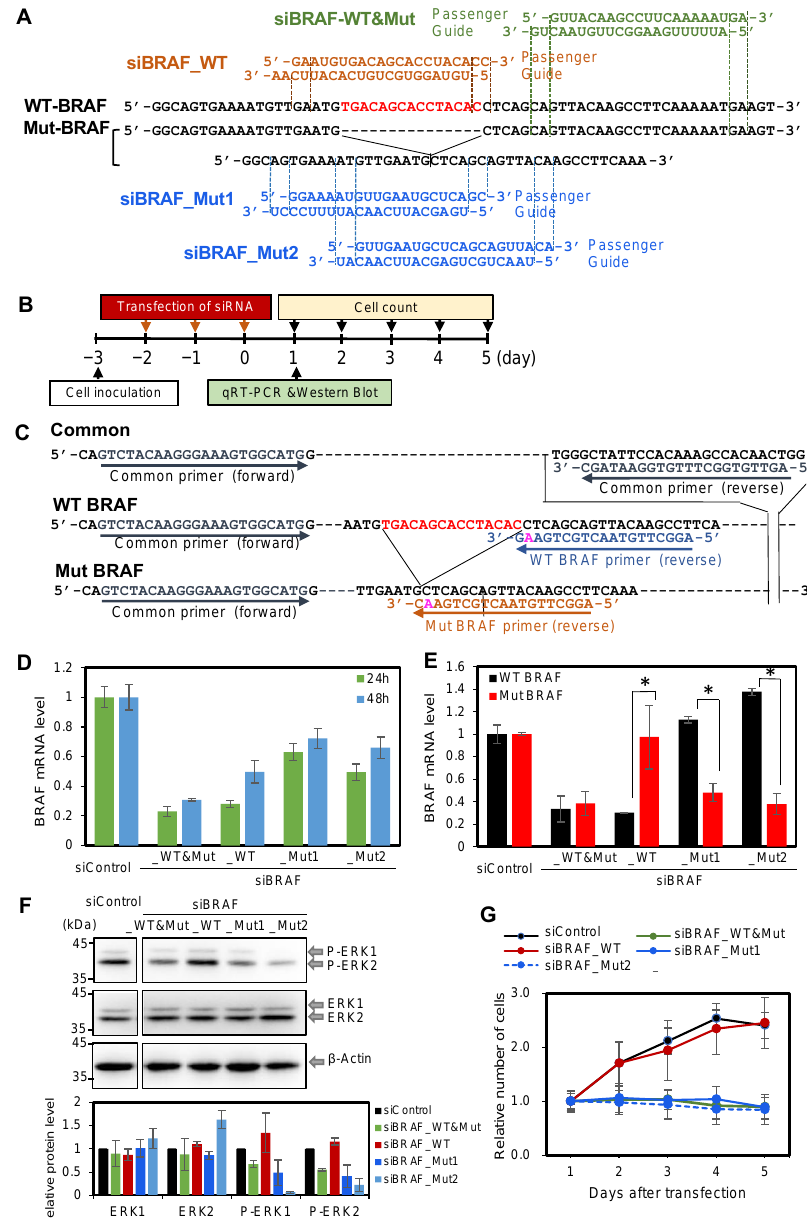
were detected by anti-ERK1/2 and anti-phospho-ERK1/2 antibodies, respectively; β -actin was used as a control. ( D ) Number of AsPC-1 cells relative to those on day 1 after three transfections of siControl or siKRAS. The black line indicates the number of AsPC-1 cells transfected with siControl, and the blue line indicates the number of cells transfected with siKRAS. The results indicate the averages of 3 independent experiments. ( E ) KRAS mRNA levels quantified by qRT-PCR in BxPC-3 cells on day 1 after three transfections of siControl or siKRAS transfections at 50 nM. The results indicate the averages of 3 independent experiments. ( F ) Western blotting using lysates of BxPC-3 cells transfected with siControl or siKRAS. ( G ) Relative number of BxPC-3 cells from 1 day after three transfections of siControl or siKRAS. The black line indicates the number of BxPC-3 cells transfected with siControl, and the blue line indicates the number of cells transfected with siKRAS. The results indicate the averages of 3 independent experiments.